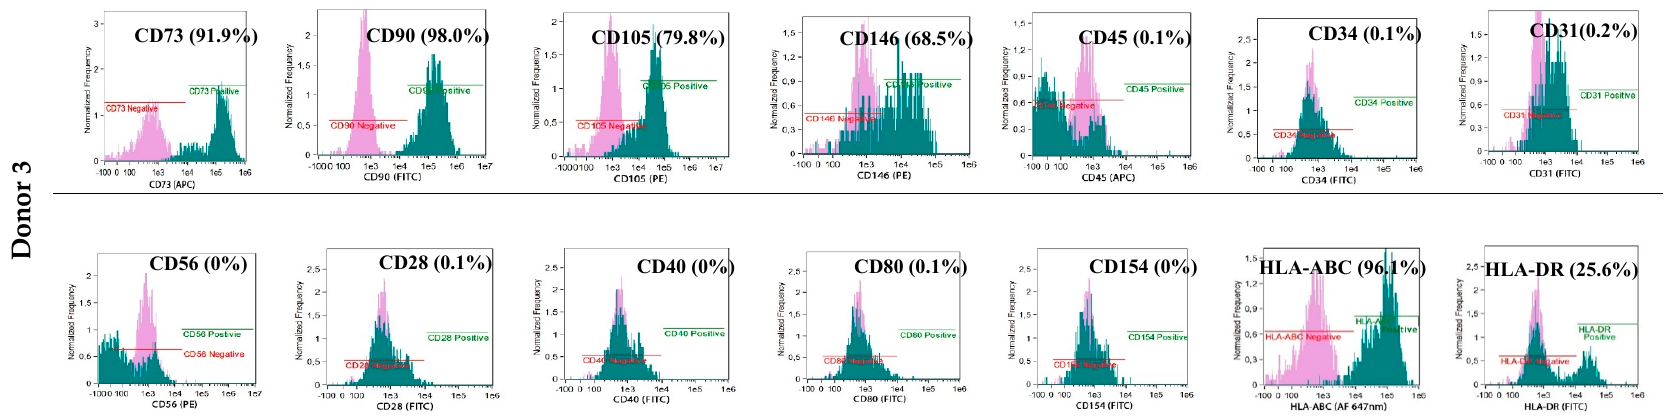
Figure 4. Phenotype of MSCs isolated from the donor’s bone marrow and delivered intramuscularly to DMD patients. Isolated BM-MSCs show the basic naïve MSC phenotype CD73 +/ CD90 +/ CD105 + , proangiogenic properties CD146 + , expression of HLA-class I antigens, lack or low expression of HLA-DR antigens, lack of co-stimulatory molecules CD28, CD40, CD80, CD154 and lack of the hematopoietic phenotype CD34, CD45.